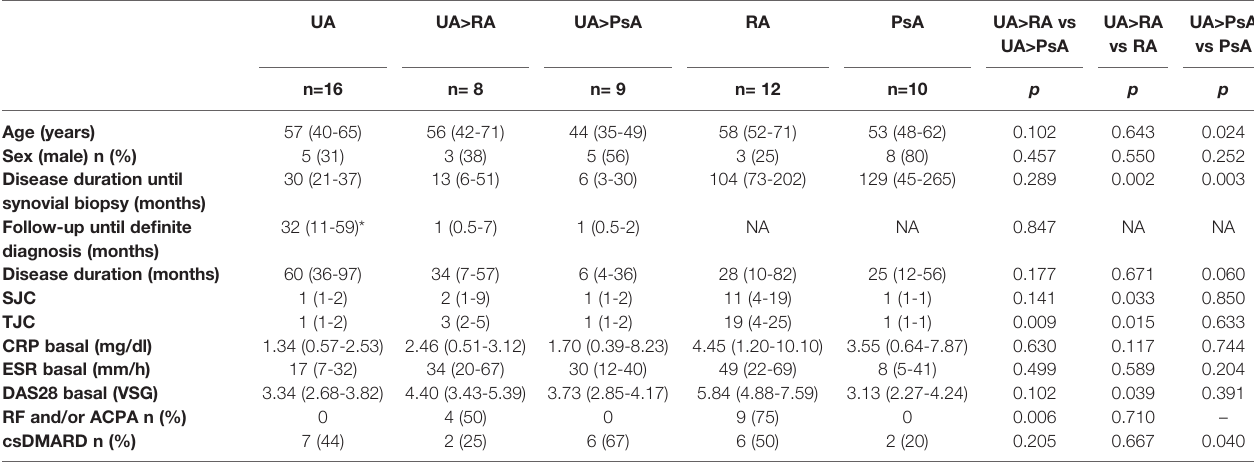
TABLE 1 | Clinical, demographic and serologic